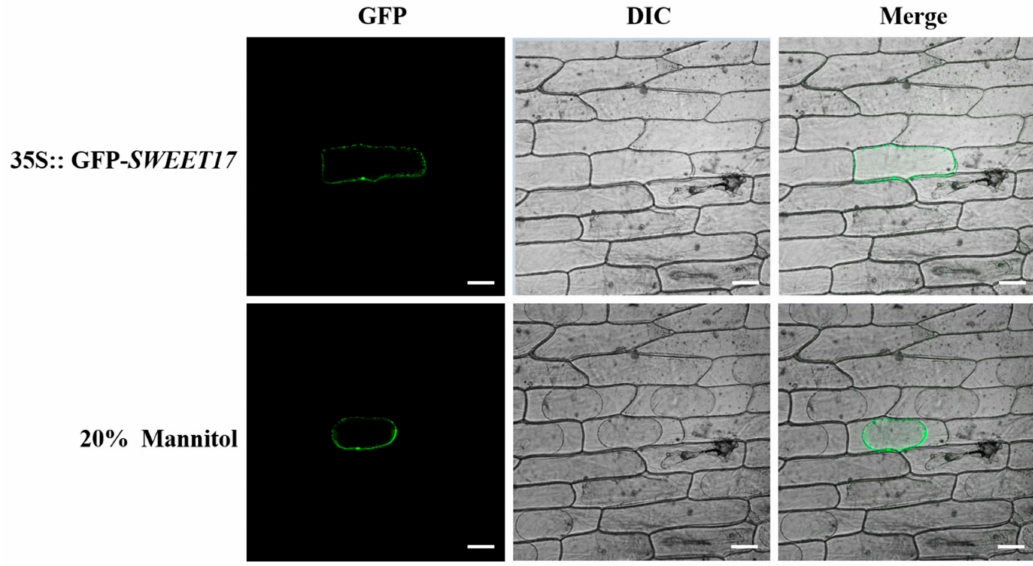
Figure 4. Subcellular localization of CmSWEET17 protein in onion epidermis cells. GFP, green fluorescence channel; DIC, bright light channel; and MERGE, overlay plots. Scale bars, 50 µ